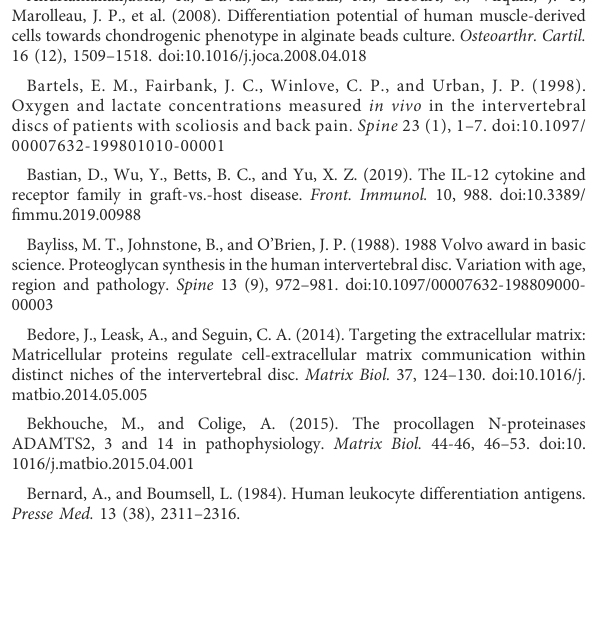
SUPPLEMENTARY FIGURE S1 Bar graphs indicate RNA levels after BISH and ImageJ analysis of NP and FAT cells after 10 days of 3D alginate bead culture under different culture conditions for genes related to the nucleus pulposus (NP) (yellow), glucose and lactate metabolism (orange), in fl ammatory markers (green), cell proliferation and senescence markers, and SA-beta galactosidase staining (blue). Cells were isolated from a single donor to avoid the genotype effect. A minimum of 25 cells were analyzed after subjecting three beads per probe, cell line, and condition to BISH. S, standard media D10 S L; D, media